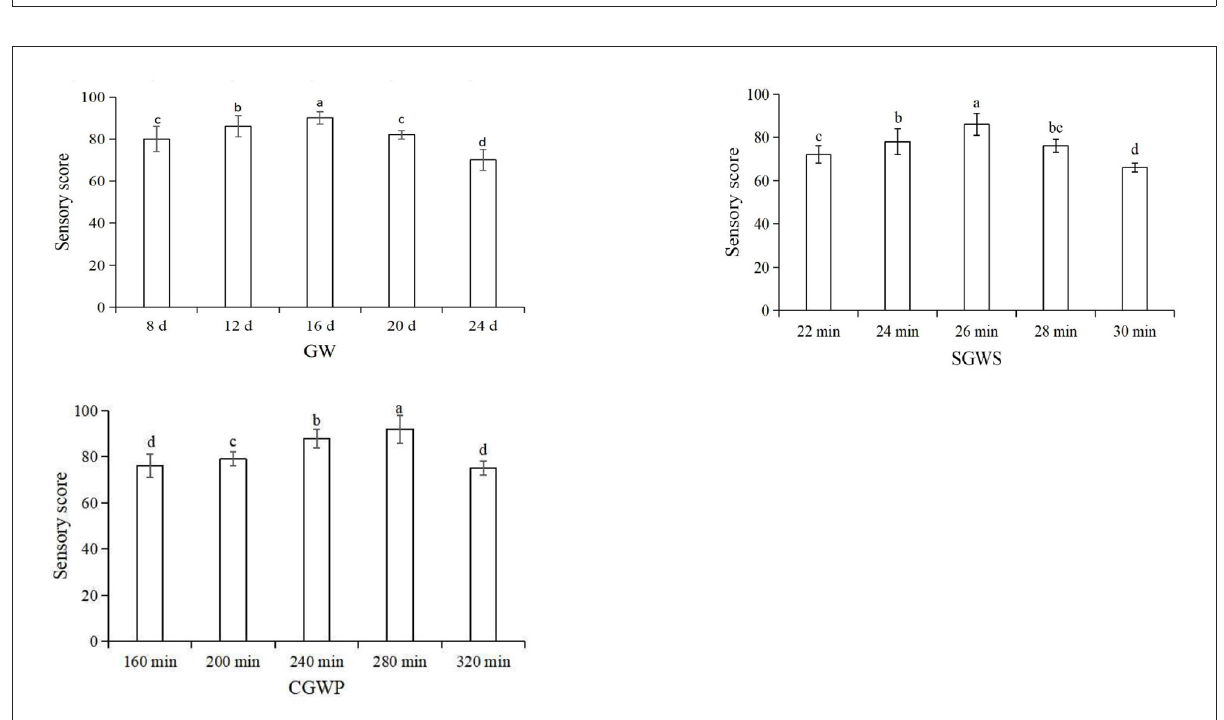
FIGURE2 Sensory scores for different processing stages of nian zhuan.